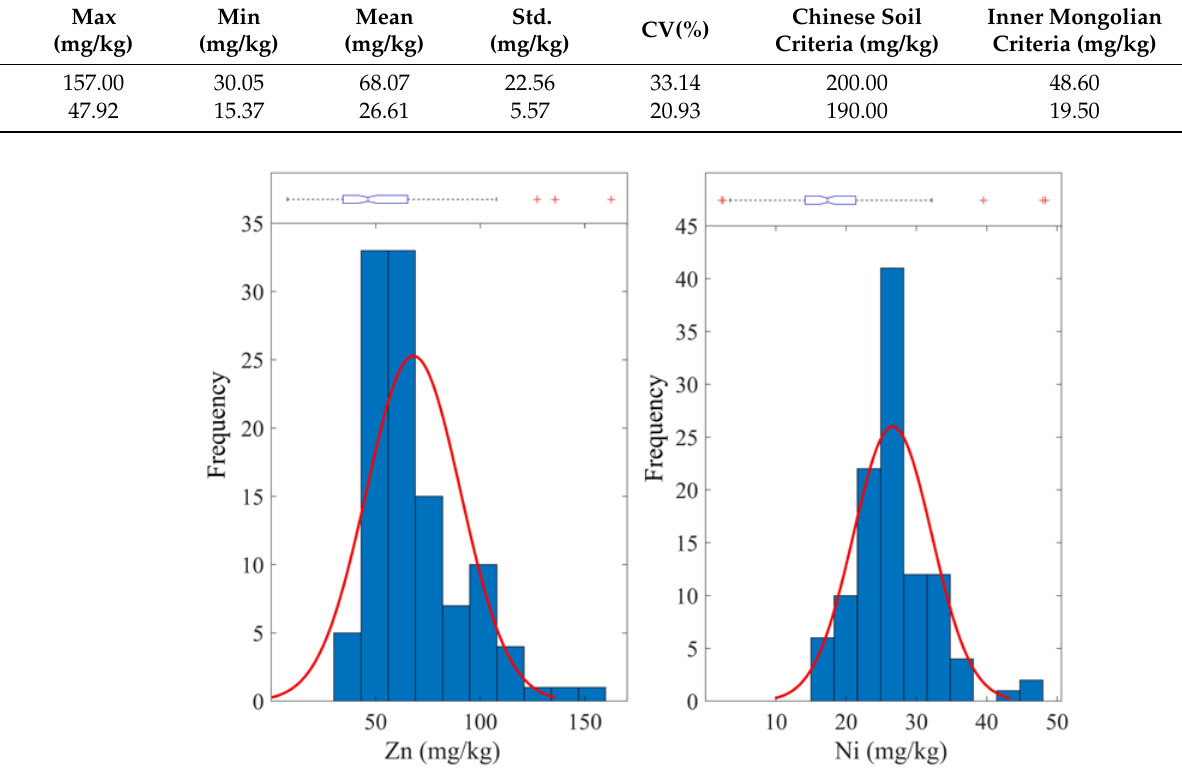
Figure 3. Histograms and box plots of Zn and Ni concentrations (No. of samples = 110). (Note: The red curve is the fitting line; “+” denotes